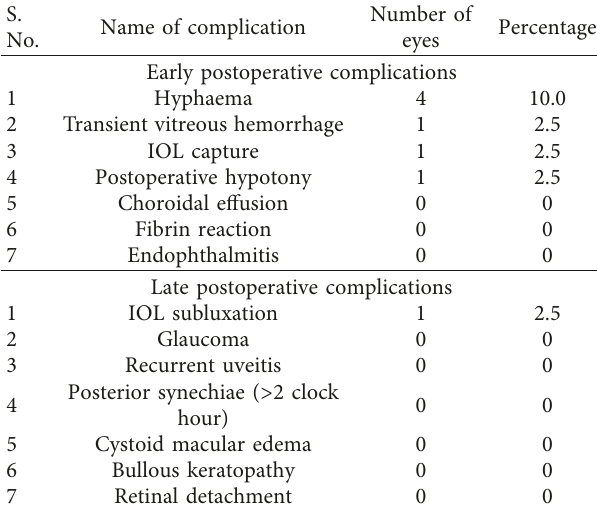
Table 2: Postoperative complications in each group.